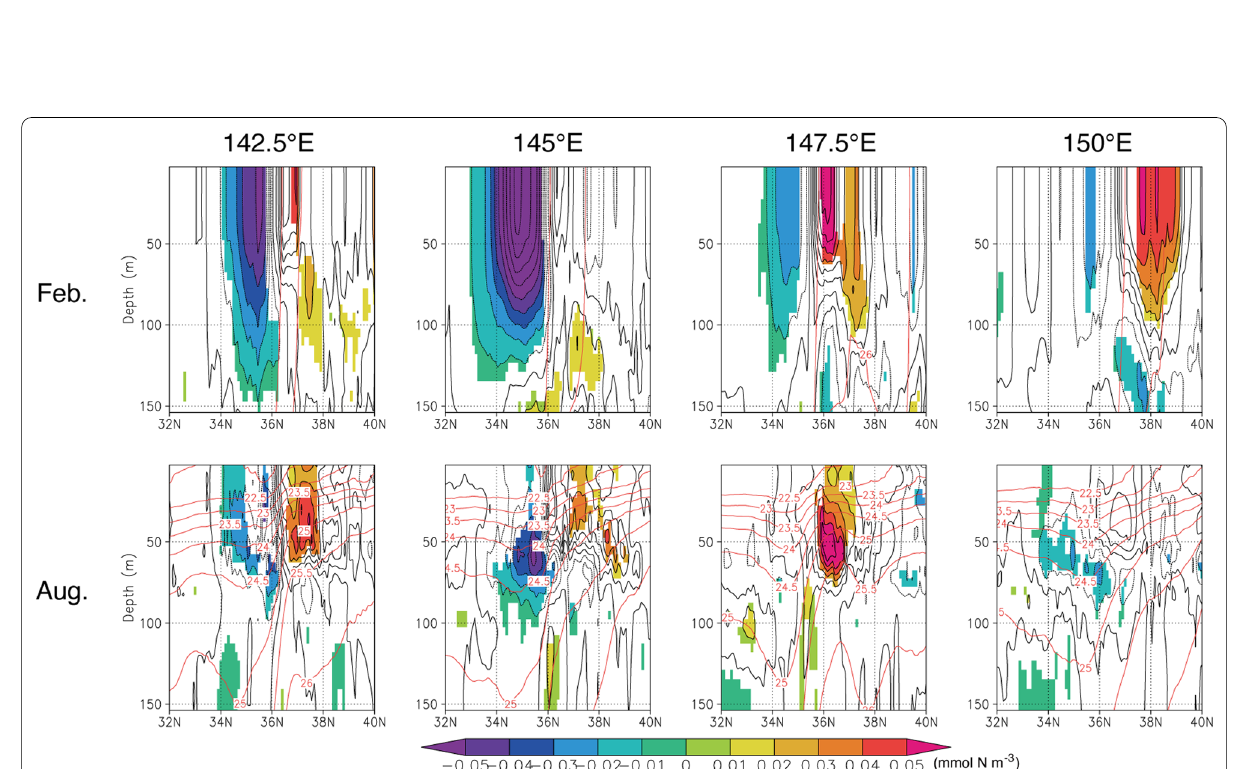
Fig. 10 As in Fig. 9, but for phytoplankton concentration anomalies (in mmol N m − 3 ). The contour intervals are 0.01 mmol N m −